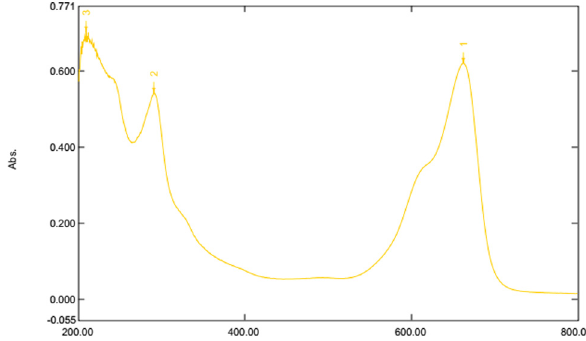
Figure 8: UV spectrum of methanolic extract of D. viscosa .